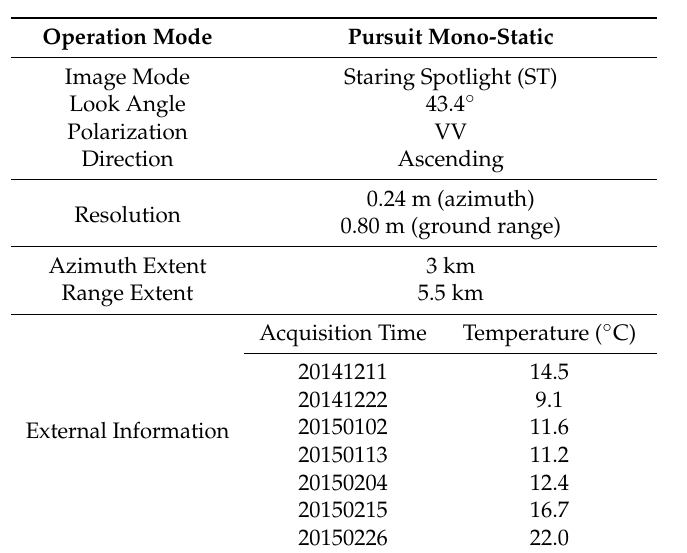
Table 1. Dataset information of pursuit monostatic data in